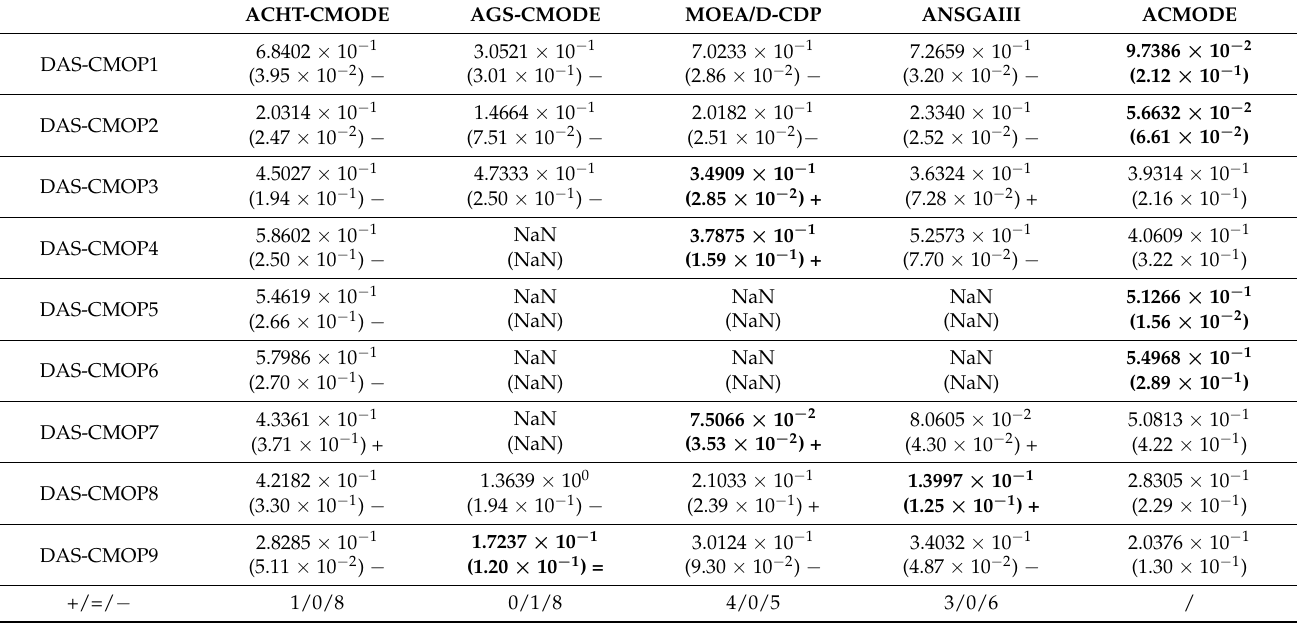
Table 10. IGD results of all comparison algorithms on DAS-CMOP test suite.